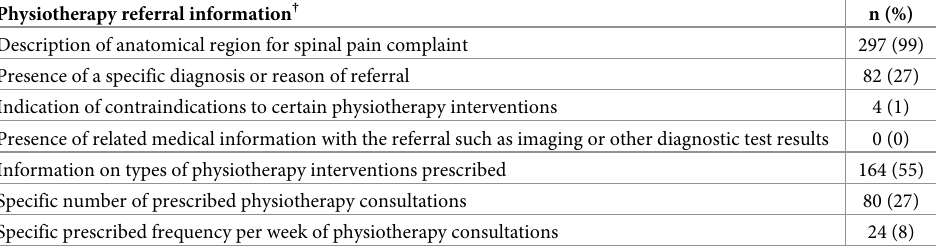
Table 3. Type of information provided by general practitioners from the physiotherapy referral of spinal pain patients (n = 300). Physiotherapy referral information † n (%) Description of anatomical region for spinal pain complaint 297 (99)